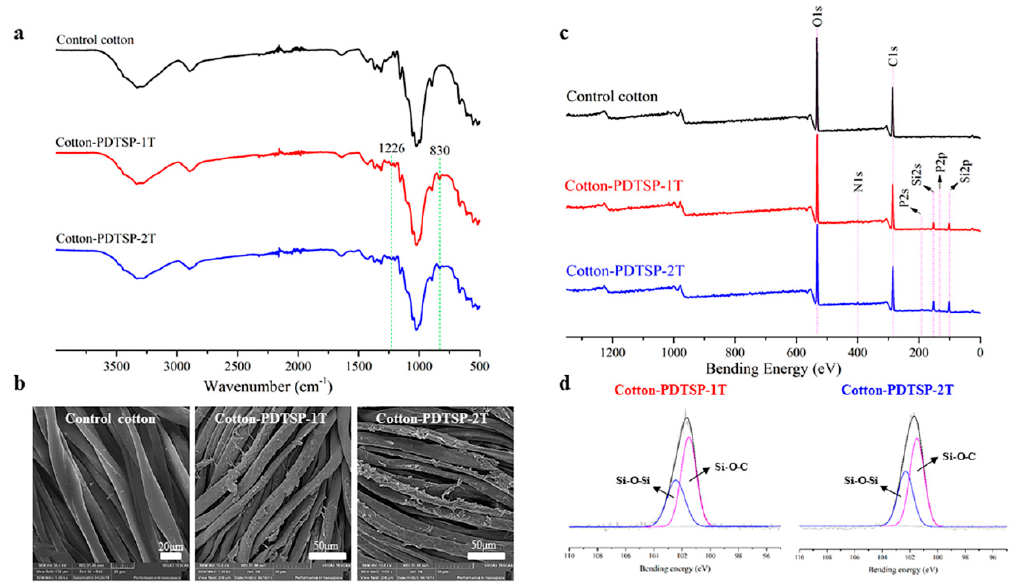
Figure 2. FT-IR spectra ( a ), SEM ( b ) and XPS ( c , d ) of Control cotton, Cotton-PDTSP-1T and Cotton-PDTSP-2T. Table 1. Add-ons and elemental composition of PDTSP-coated cotton fabrics.